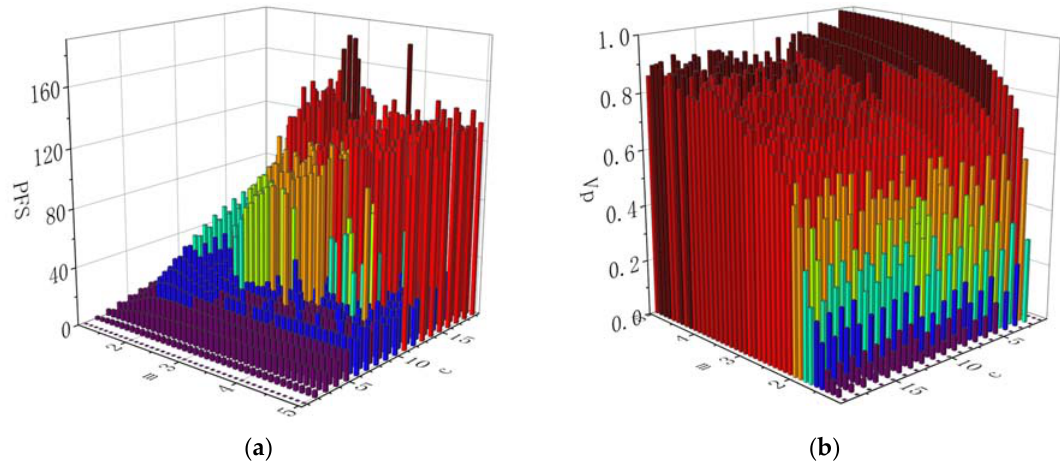
Figure 5. ( a ) PFS value under different values of c and m ; ( b ) Vp value under different values of c and m .